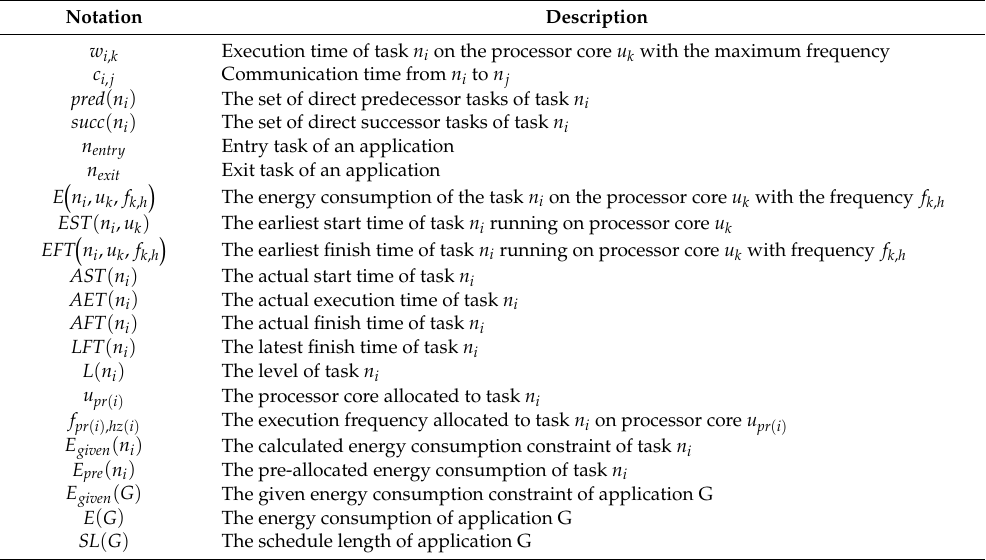
Table 1. The main notations we